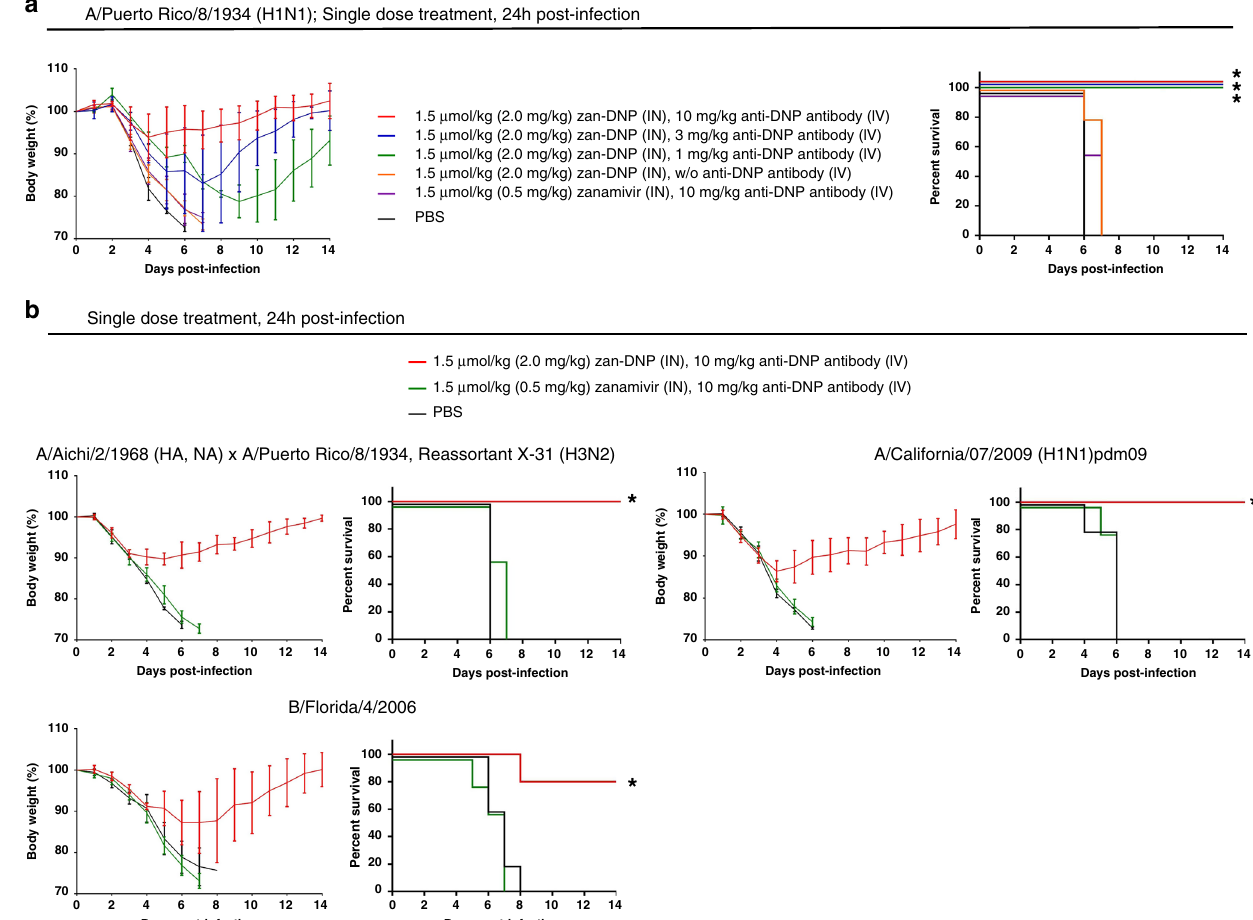
Fig. 6 Therapeutic ef fi cacy of co-administration of zan-DNP plus exogenous anti-DNP antibodies in protecting nonimmunized mice from a lethal in fl uenza virus infection. a Nonimmunized BALB/c mice were challenged with 100x MLD 50 of in fl uenza virus A/Puerto Rico/8/1934 (H1N1) prior to treatment with a single dose of 1.5 μ mol/kg zan-DNP (intranasal administration, IN) plus exogenous anti-DNP antibodies (1 – 10 mg/kg, intravenous administration, IV) 24 h post-infection (3 mice/group for 3 mg/kg and 1 mg/kg anti-DNP antibody treatment groups, 5 mice/group for the rest of the groups). Control groups include (i) substitution of zanamivir for zan-DNP, (ii) omission of anti-DNP antibodies, and (iii) treatment with PBS. b Nonimmunized BALB/c mice (5 mice/group) were challenged with the indicated strains of in fl uenza virus prior to treatment with a single dose of 1.5 μ mol/kg zan-DNP or zanamivir (IN) plus 10 mg/kg exogenous anti-DNP antibodies (IV) 24 h post-infection. Mice were counted as dead when they lost either 25% of their initial weight or became moribund. Statistical differences between PBS and drug treatment groups were determined by two-sided log- rank test (* P < 0.005, see exact P values in Supplementary Table 1). Body weight change (%) are presented as mean values ±